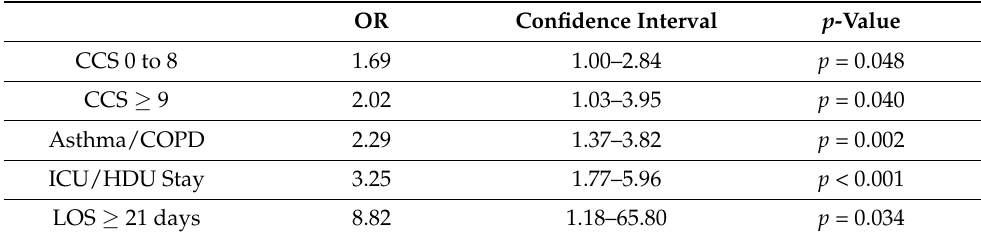
Table 3. Coefficients and odds ratio estimates outlining the risks/associations of HAP. OR Confidence Interval p -Value CCS 0 to